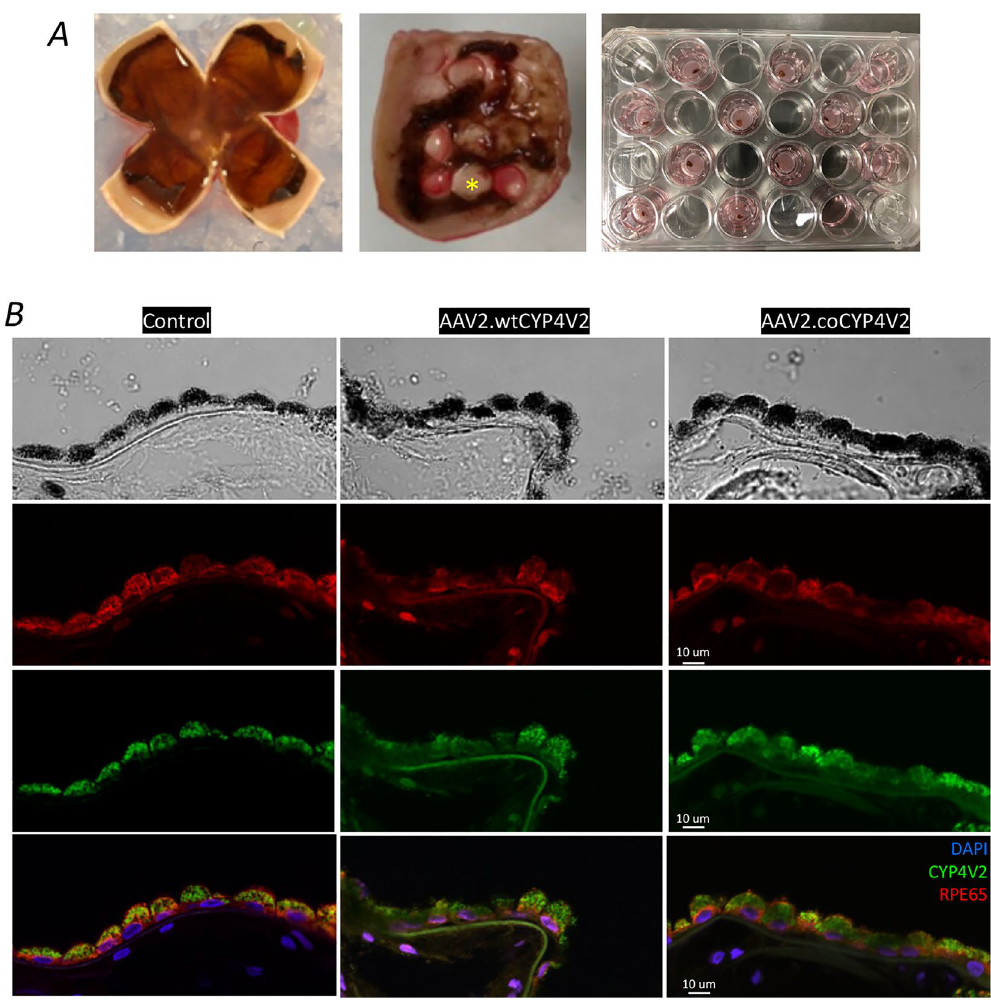
Figure 5. CYP4V2 expression in human RPE from retinal explant ex vivo culture transduced with AAV2. ( A ) The process of setting up ex vivo cultures of the human retina. Star indicates the 4 mm-diameter circular neural retinas and RPE/choroid trephined from the eye using a Biopsy Punch. ( B ) Immunohistochemistry showed a relatively stronger expression of CYP4V2 in the human RPE ex vivo culture transduced with AAV2.coCYP4V2 compared with those transduced with